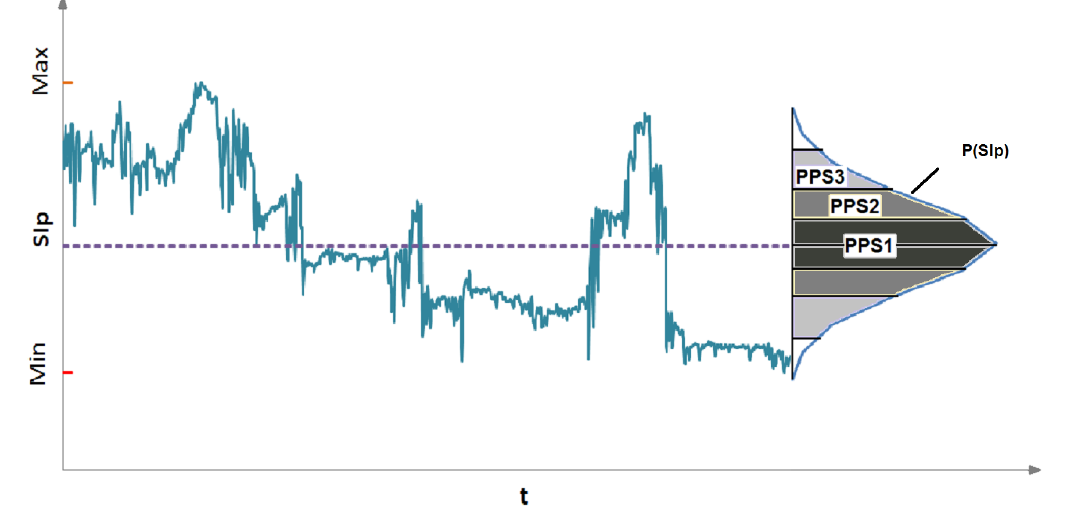
Figure 6. The formation of the probability density function of stress index P(SIp) by the example of 3 psychophysiological